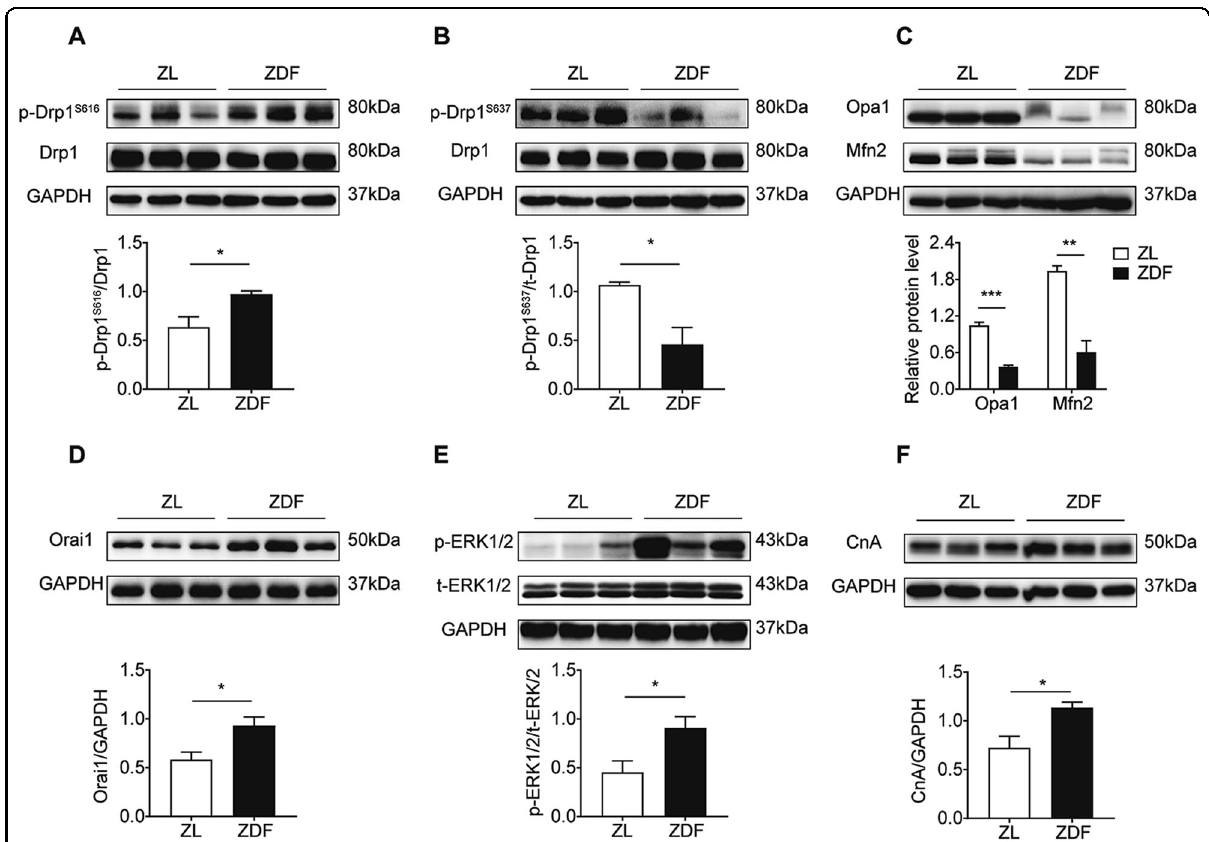
Fig. 2 Expression levels of mitochondrial dynamics and calcium handling pathway-related proteins in a hypertrophic hearts of ZDF rats. A Western blotting images and summarized data showing phospho-Drp1 (S616) and total Drp1 protein levels in the ventricular tissue of ZL and ZDF rats ( n = 6). B Western blotting images and summarized data showing phospho-Drp1 (S637) and total Drp1 protein levels in the ventricular tissue of ZL and ZDF rats ( n = 6). C Western blotting images and summarized data showing Mfn2 and Opa1 protein levels in the ventricular tissue of ZL and ZDF rats ( n = 6). D – F Western blotting images and summarized data showing Orai1, phospho-ERK1/2, total ERK1/2, and CnA protein levels in the ventricular tissue of ZL and ZDF rats ( n = 6). Data are shown as mean ± SEM. * P < 0.05, ** P < 0.01, and *** P < 0.001 vs ZL